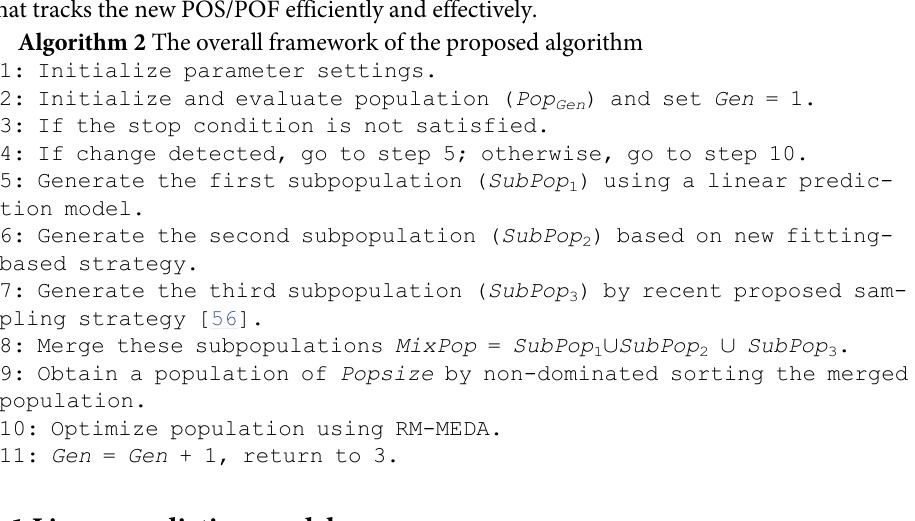
Algorithm 2 The overall framework of the proposed